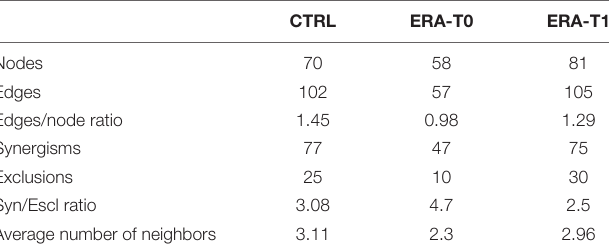
TABLE 2 | Topological parameters of co-occurrence networks computed for each group/time-point. CTRL ERA-T0